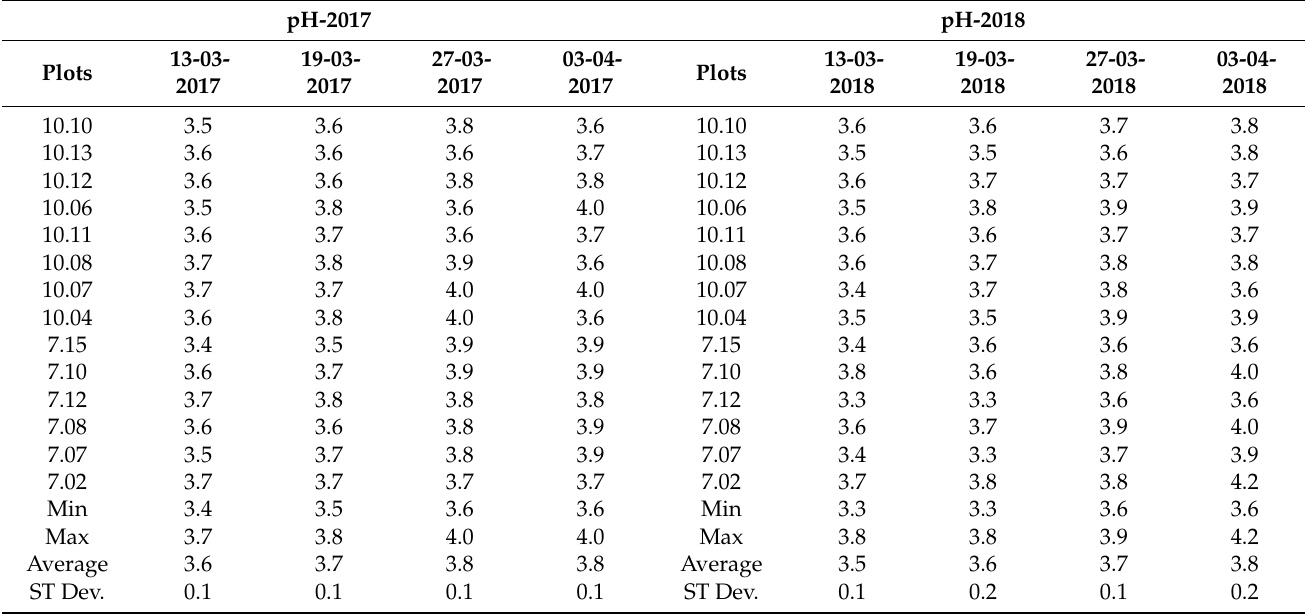
Table 2. Field pH sampling